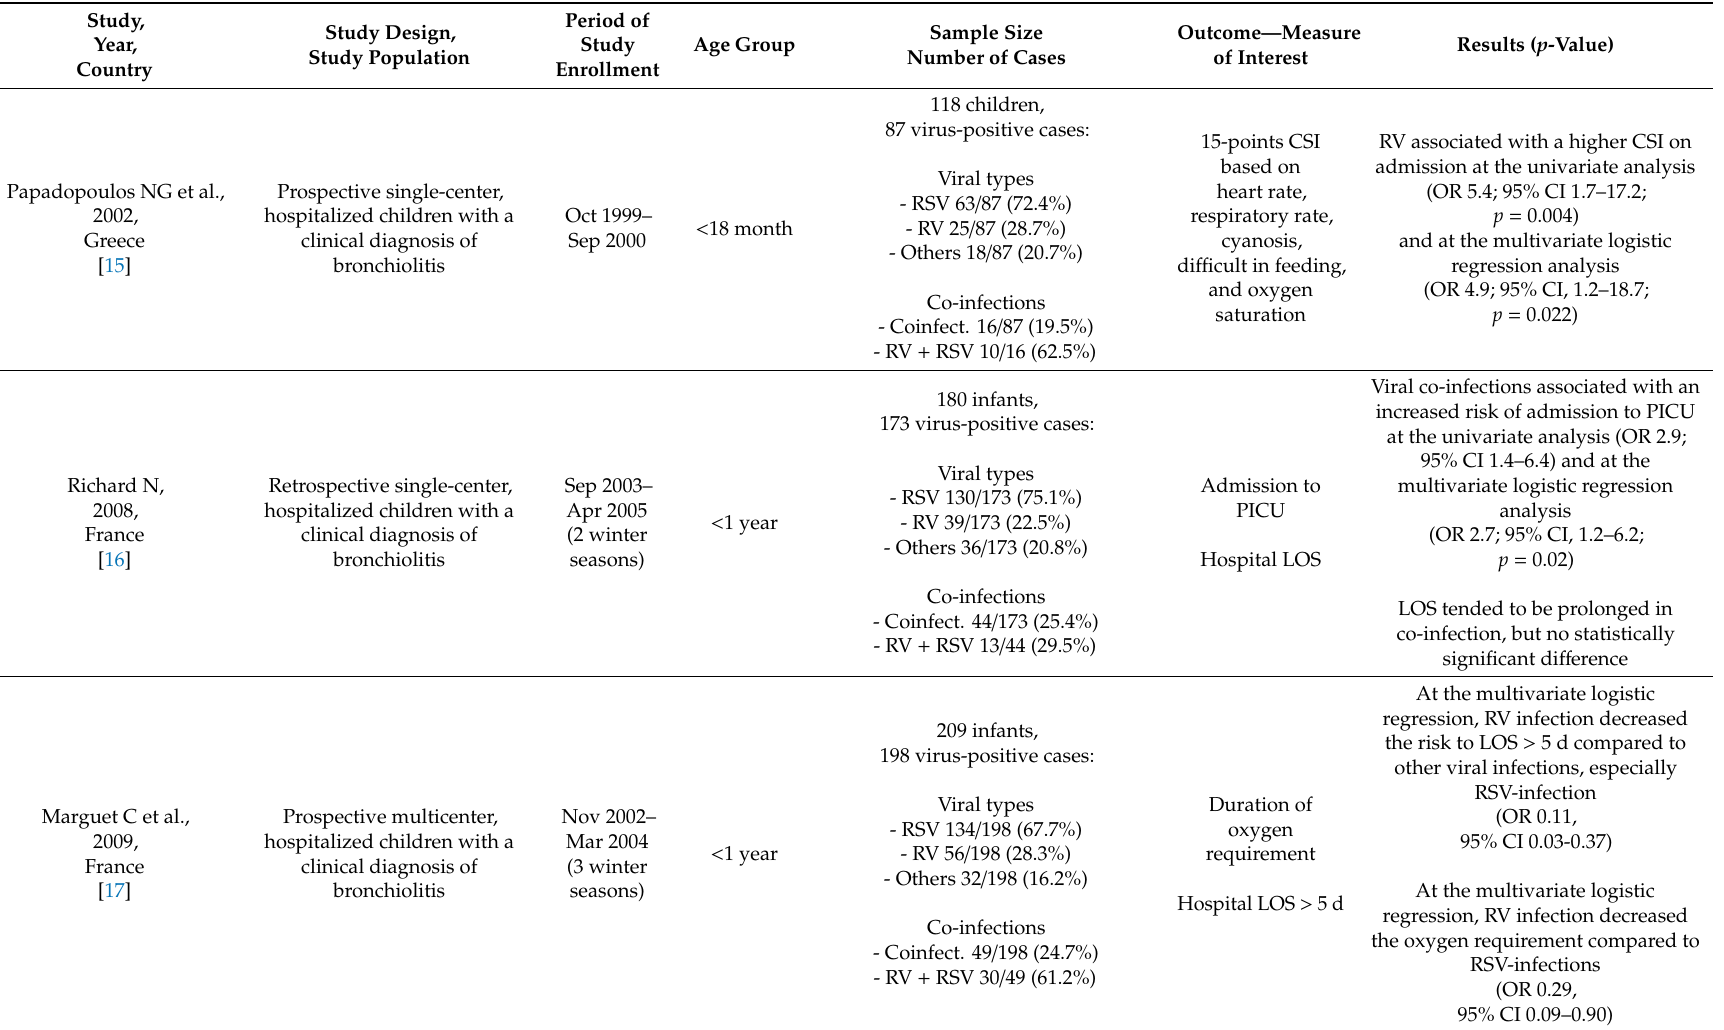
Table 1. Principal studies evaluating the correlation between rhinovirus and severity of illness in children with